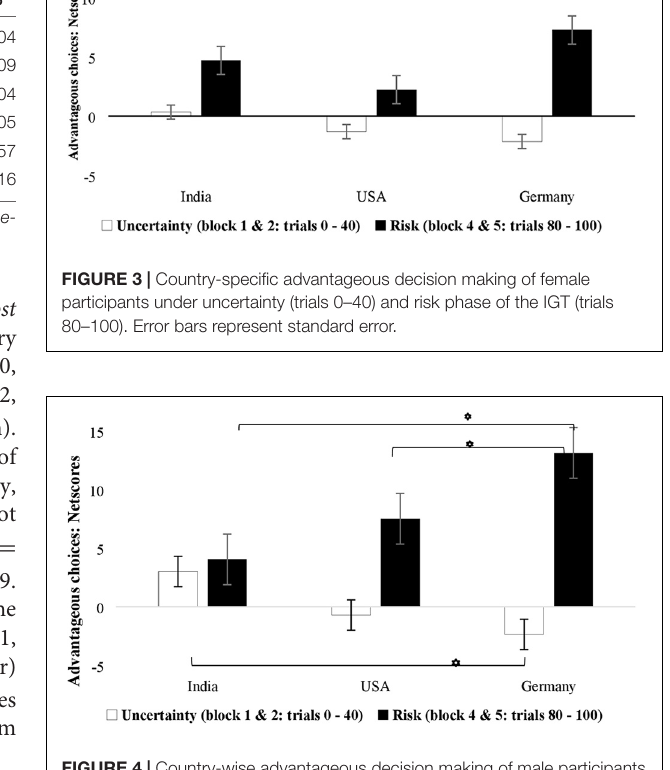
FIGURE 4 | Country-wise advantageous decision making of male participants under uncertainty (trials 0–40) and risk phase of the IGT (trials 80–100) suggests greater change in advantageous decision making from uncertainty to the risk phase occurred in case of Germany. Error bars represent standard